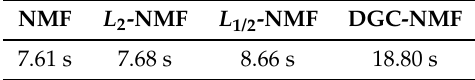
Table 1. Comparison of the time cost of different